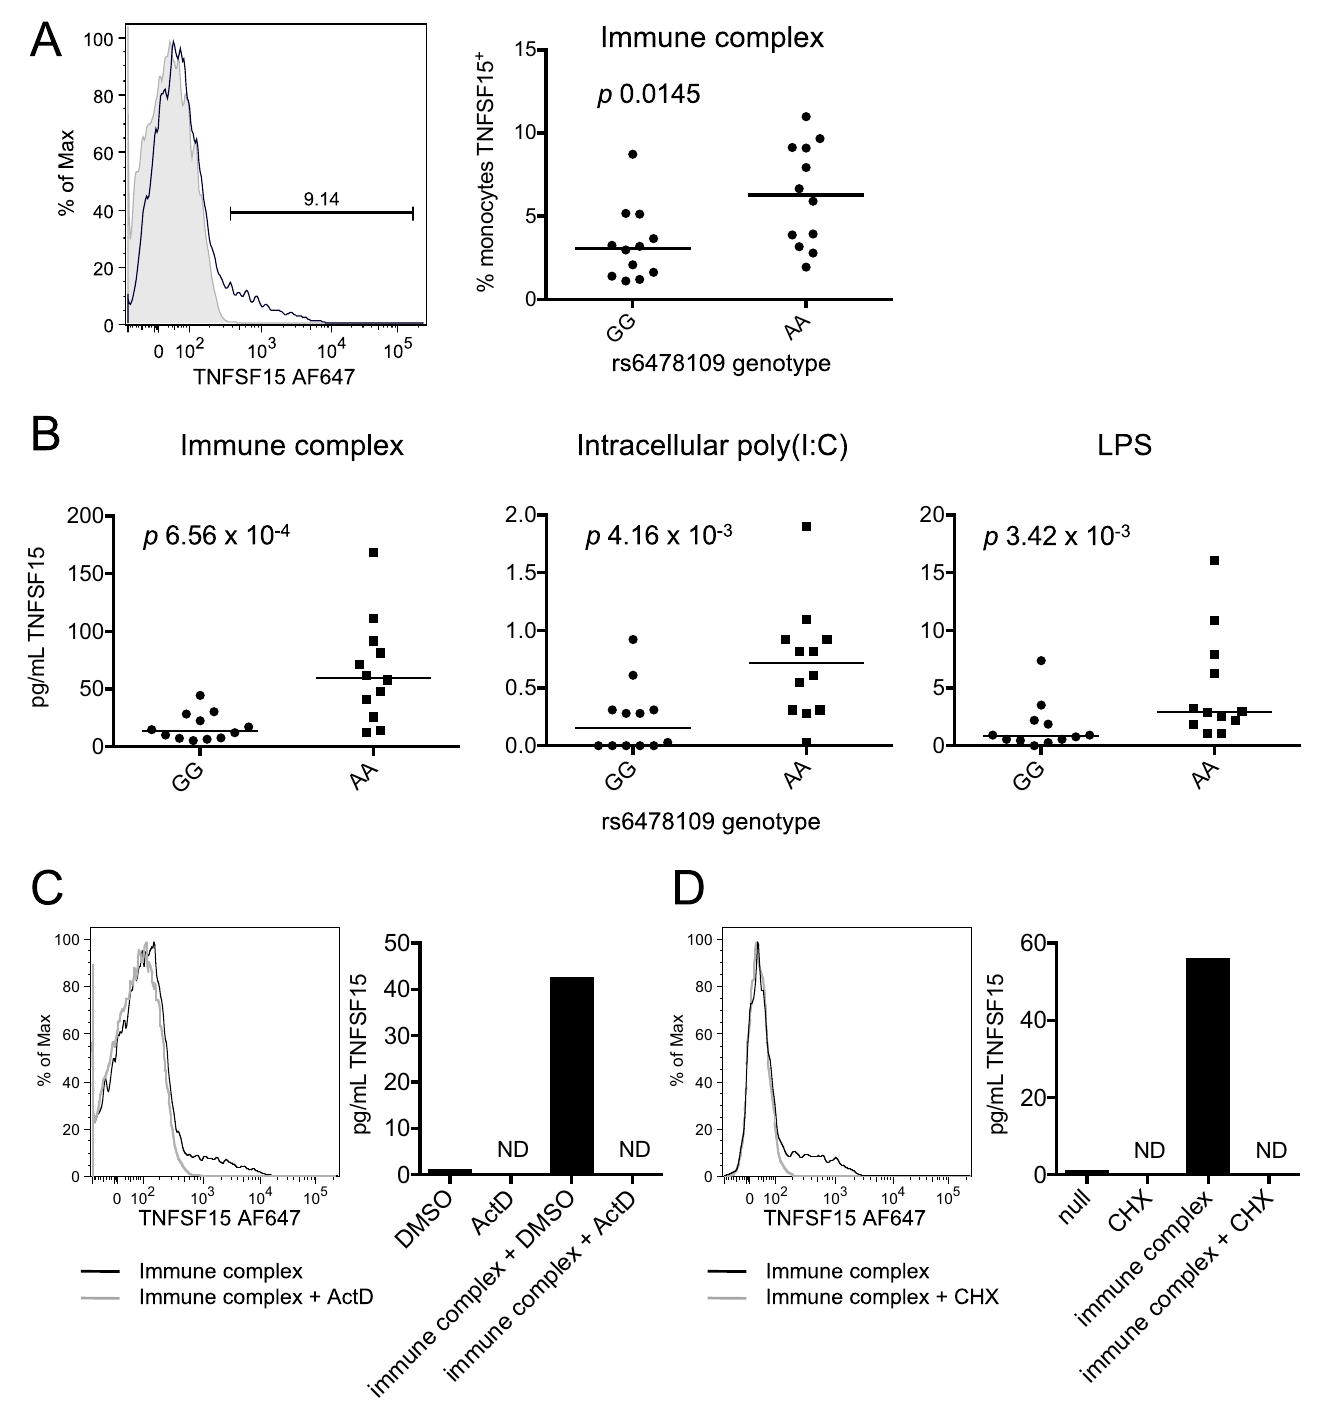
Fig 3. Genotype is associated with de novo TNFSF15 protein production in stimulated monocytes. ( A ) An example of gating for TNFSF15 + monocytes after 4 hours immune complex stimulation is depicted (left). Black line = monoclonal anti-TNFSF15; grey shading = isotype control. Percentages of TNFSF15 + monocytes after immune complex stimulation are quantified for GG (n = 12) and AA (n = 12) homozygous individuals (right). ( B ) Soluble TNFSF15 was measured in supernatants of monocytes from GG (n = 12) and AA (n = 12) homozygous individuals after the indicated 4-hour stimulations by custom anti-TNFSF15 Bio-Plex assay. p values are from Mann-Whitney test. ( C ) Monocytes were stimulated with immune complex for four hours in the presence of actinomycin D (ActD) or dimethyl sulfoxide (DMSO) control. ND indicates none detected. ( D ) As (C) in the presence or absence of cycloheximide (CHX). (C) and (D) are representative of two independent experiments